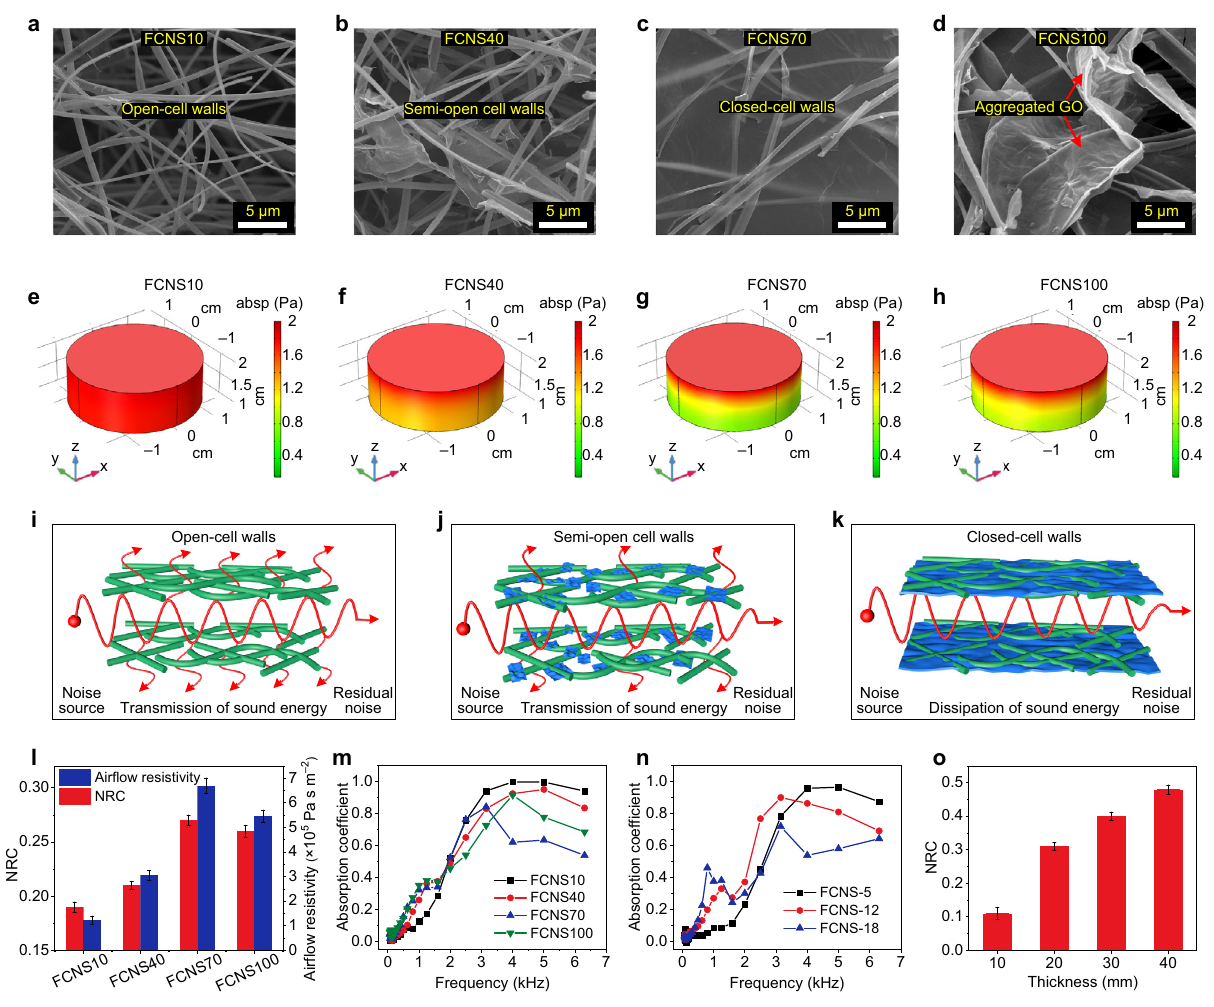
Fig. 4 Sound absorption properties of FCNSs. SEM images showing the cell walls of a FCNS10, b FCNS40, c FCNS70, and d FCNS100. e – h The corresponding absolute sound pressure distribution of various FCNSs. Schematic illustrations of the sound absorption mechanism for i open-cell walls, j semi-open cell walls, and k closed-cell walls. l In fl uences of GO loading amount on NRC and air fl ow resistance of the FCNSs. m Variation of the absorption coef fi cient of the relevant FCNSs. n Effects of density on the absorption coef fi cient of FCNSs. o NRC of FCNS-5 with various thicknesses. Error bars in l , o represent the standard deviations of three comparison between experimental values and designed values is described in Supplementary Discussions.